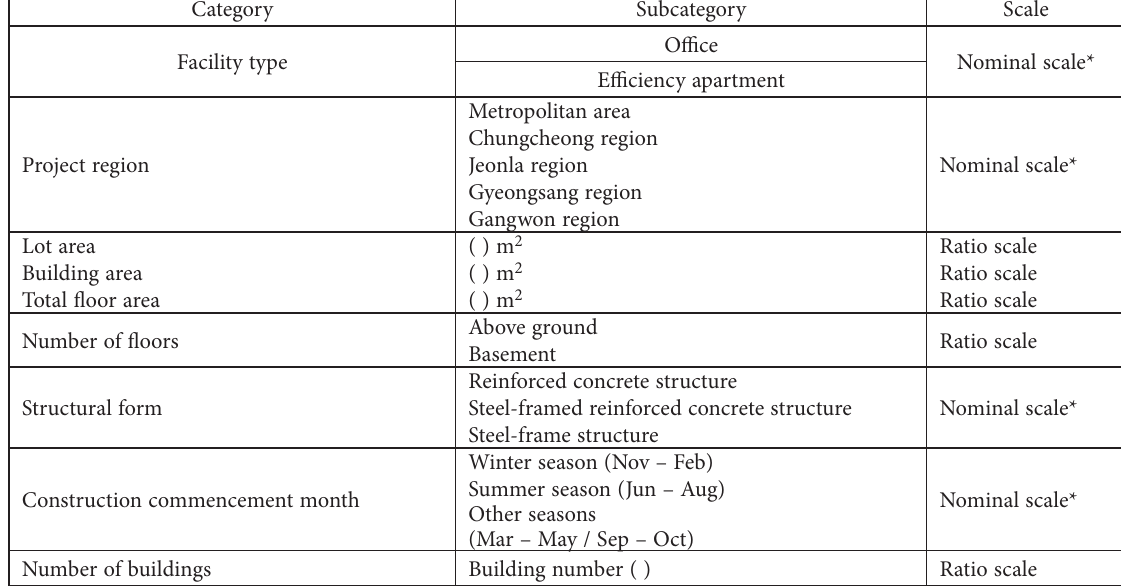
Table 4. Establishment and characteristics of the independent variables for the prediction